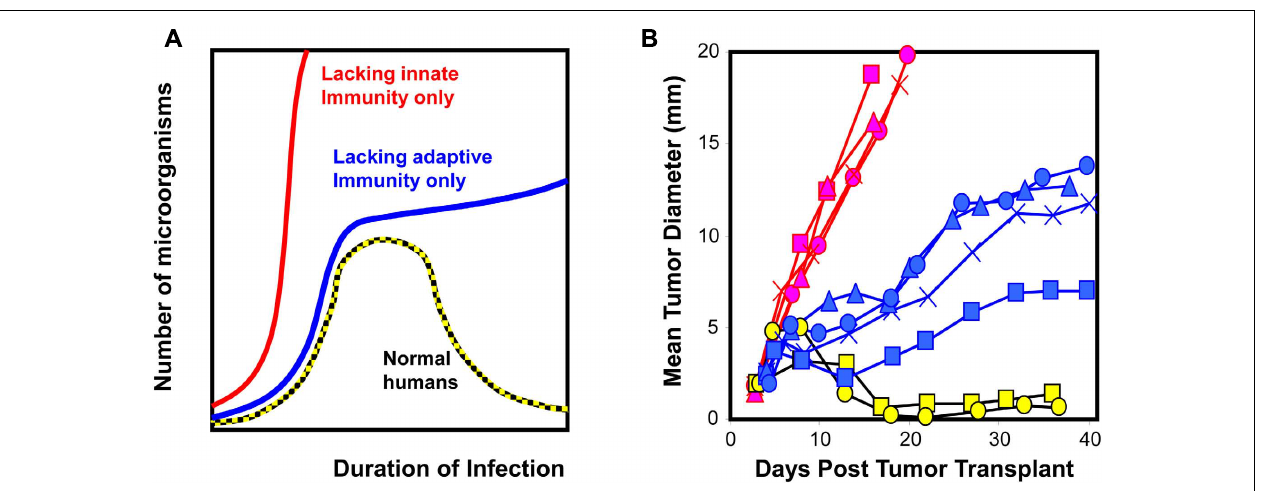
FIGURE 1 | Cellular homeostasis is a dynamic process that includes both innate and adaptive immunity. (A) The dynamics associated with immune surveillance to microorganisms in humans and mice (Murphy etal., 2007). (B) Similarly, clones derived from 3’ methylcholanthrene-induced sarcomas exhibit different phenotypic dynamics upon transplantation [WT clones transplanted into RAG2 − / − hosts (red) and RAG2 − / − clones transplanted intoWT hosts (blue and yellow; O’Sullivan etal., 2012)]. Restoring homeostasis that microorganisms or tumor cells are not present in